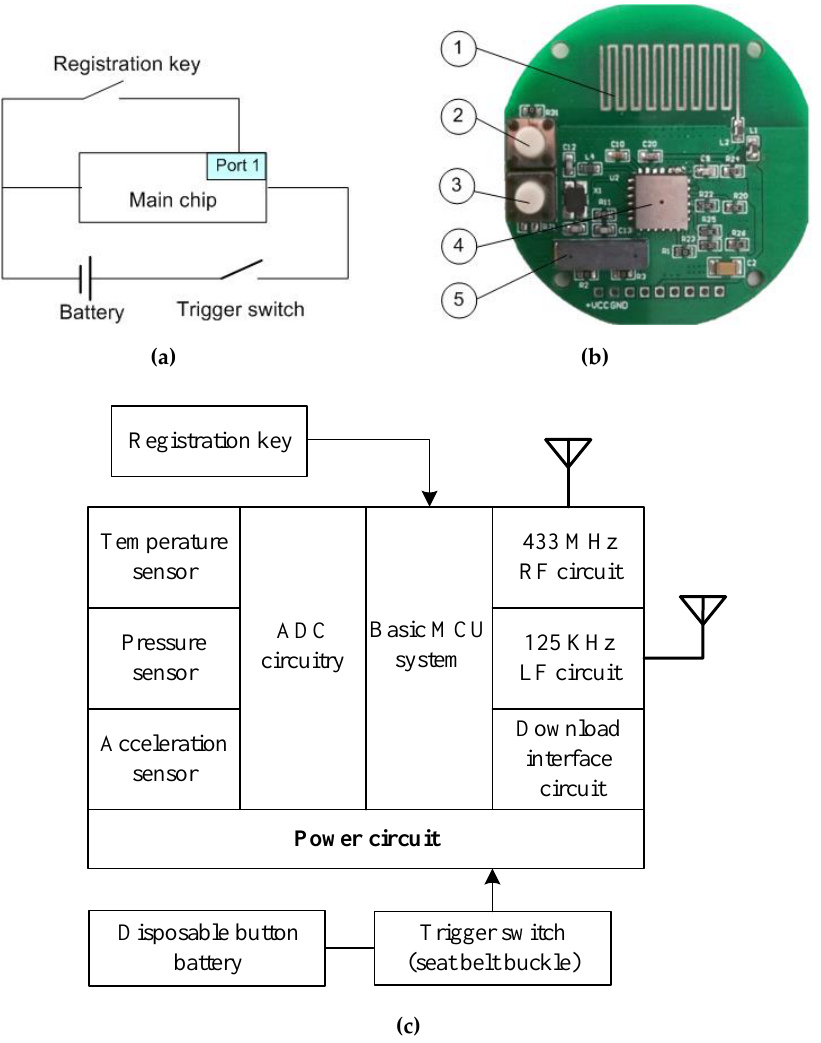
Figure 4. ( a ) The node schematic. ( b ) Node PCB diagram: (1) the RF antenna, (2) the trigger switch, (3) the registration key, (4) the main chip, (5) a 125 KHz low-frequency burning inductor. ( c ) Node internal structure.